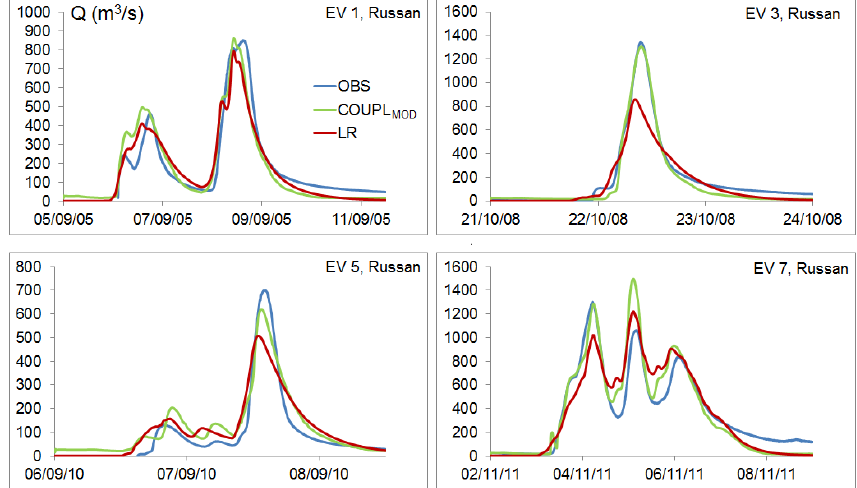
Figure 5. Hydrographs modelled for event nos. 1, 3, 5 and 7 according to the COUPL MOD and LR modelling options, at the Russan